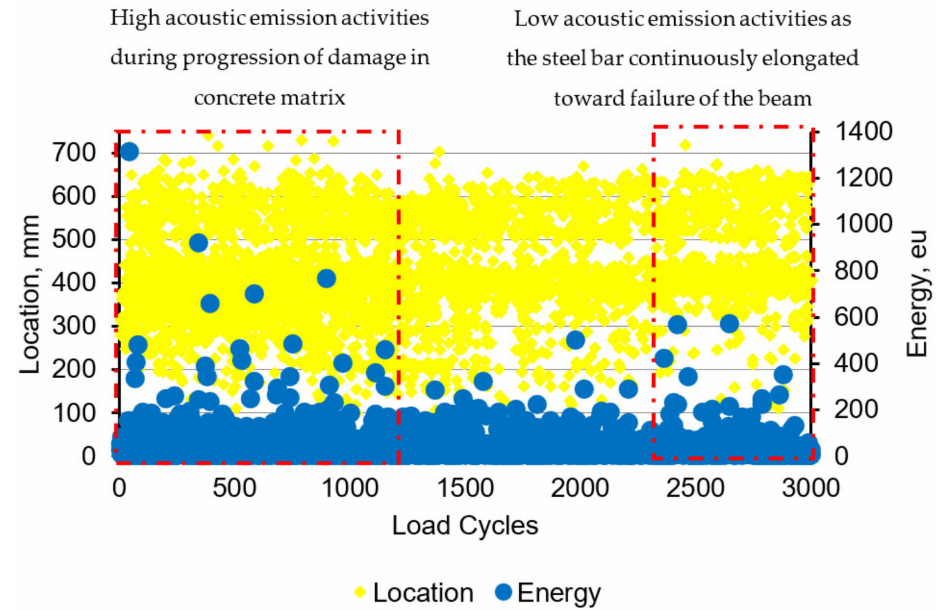
Figure 17. Distribution of the acoustic emission activities based on the